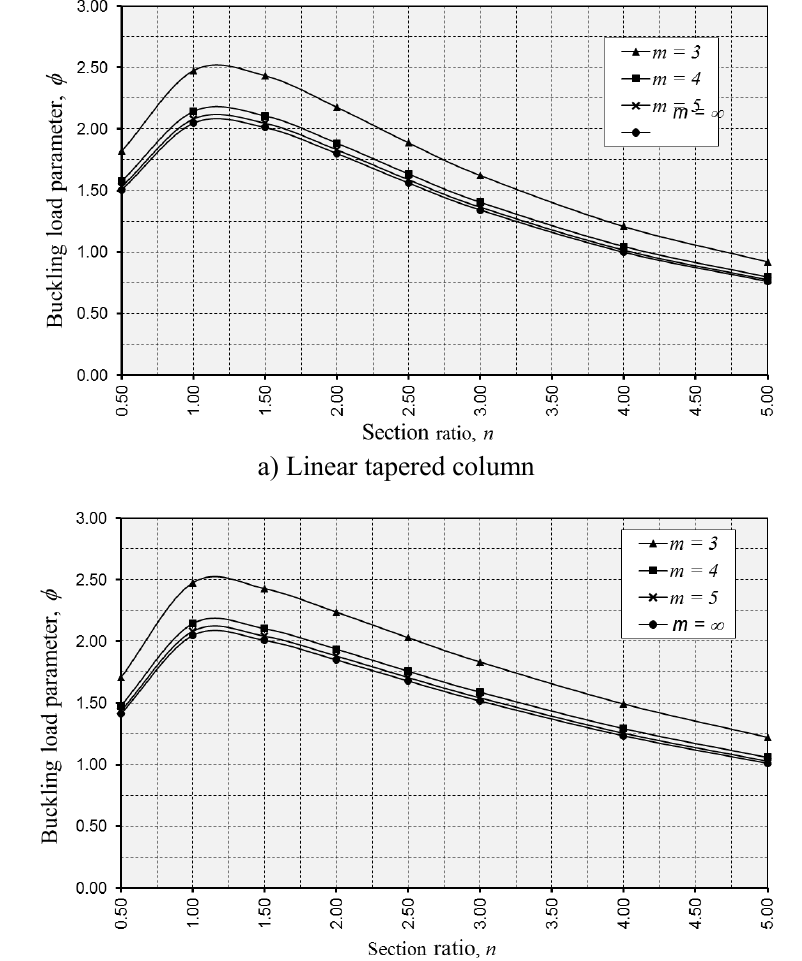
Fig. 3. Buckling load parameter of tapered columns with pinned